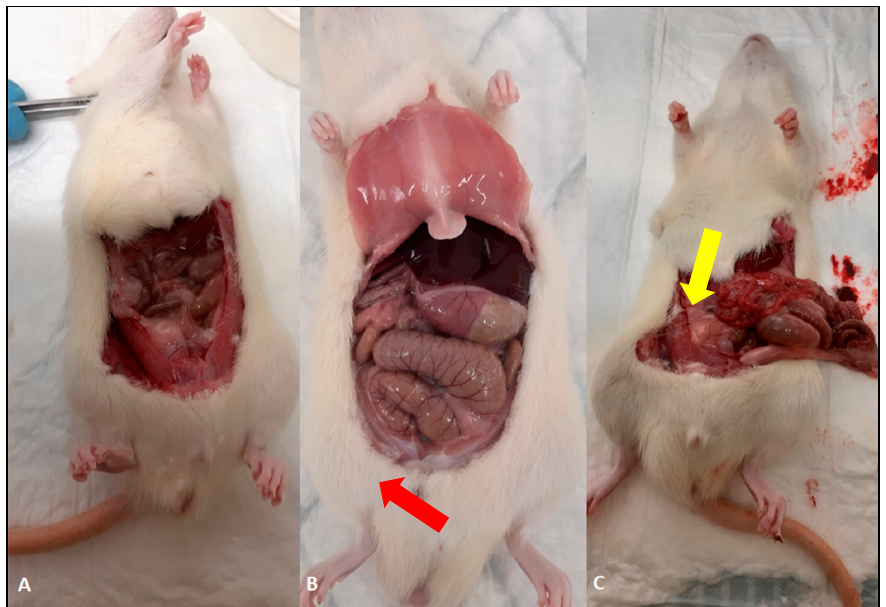
Figure 3. Macroscopical evaluation of C. difficile infection in the large and small intestines. ( A ) Normal macroscopical finding in the Xanthohumol treated rat; ( B ) edema in the large intestine (red arrow) and ( C ) hyperemia in the small intestine in infected untreated rats (yellow arrow).